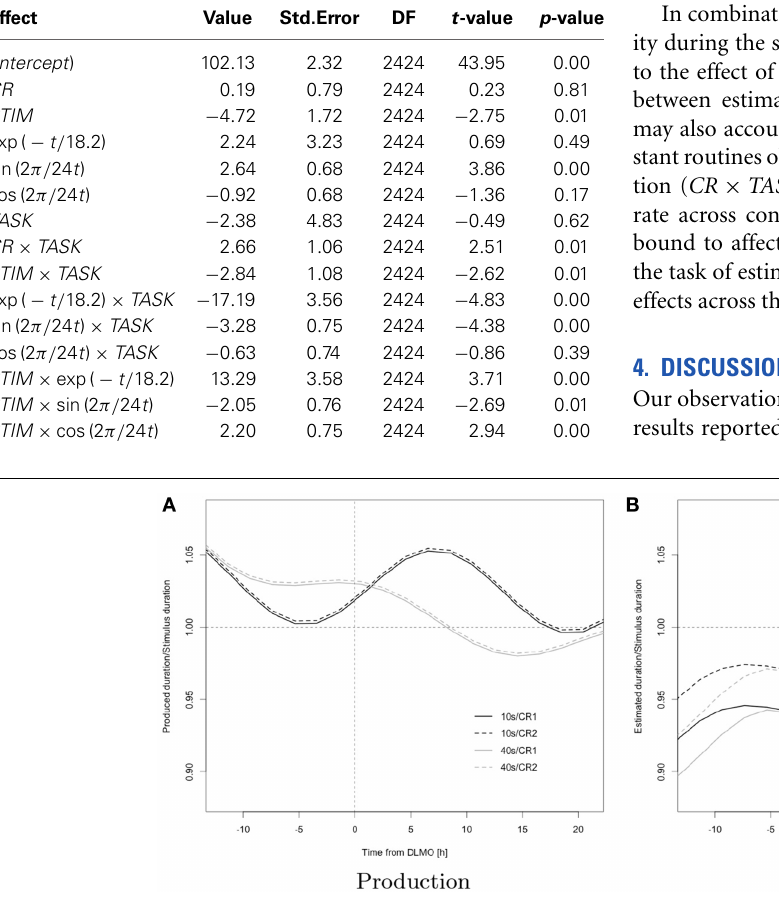
FIGURE 4 | Model predictions; black, 10s; gray, 40s; solid, CR1; dashed, CR2; the horizontal reference line represents veridical timing; the vertical reference line represents dim light melatonin onset